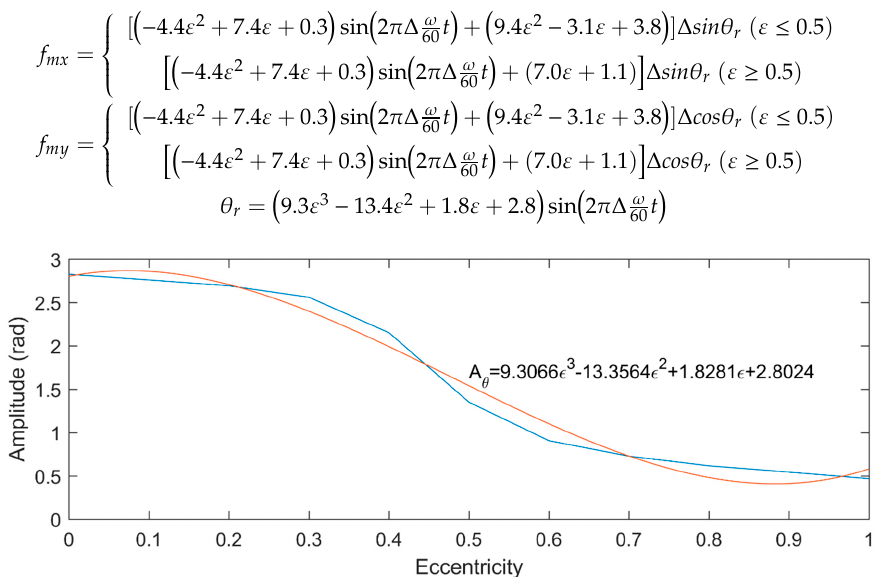
( b ) Figure 10. Variation of the UMF and its direction angle at different rotor speed. ( a ) UMF; ( b ) direction angle of the UMF. 3.2. Simulation of Nonlinear Dynamic Behavior of the ABMS In this section, the multifield coupling model of rotor dynamics is analyzed. The detailed data of the air journal bearing is listed as follows: 𝐿 = 0.1 m,𝑅 = 0.05 m,𝐶 (cid:3045) = 2 (cid:3400) 10 (cid:2879)(cid:2873) m,𝜇 = 1.82 (cid:3400) 10 (cid:2879)(cid:2873) P (cid:2911) ∙ s,𝑃 (cid:3045) = 4 atm. Set the rotor to a certain initial position, chose the parameter 𝜔 = 3000 rpm ( Λ = 1.058 ), a static load 𝑓 (cid:3032) = 100 − N was loaded on the rotor ( 𝐹 (cid:3032) = 0.0987 ). Moreover, the dynamic behavior of the rotor with and without considering the UMF was investigated. Figure 11a shows the rotor center trajectory without considering the UMF at 𝐹 (cid:3032) = 0.0987 , 𝑀 = 0.1071 and Figure 11b shows the rotor center trajectory with considering the UMF at the same condition. It can be seen that the UMF changes the converge position, but not obvious. In the meanwhile, the UMF helps to accelerate the convergence of the rotor center trajectory as shown in Figure 12.